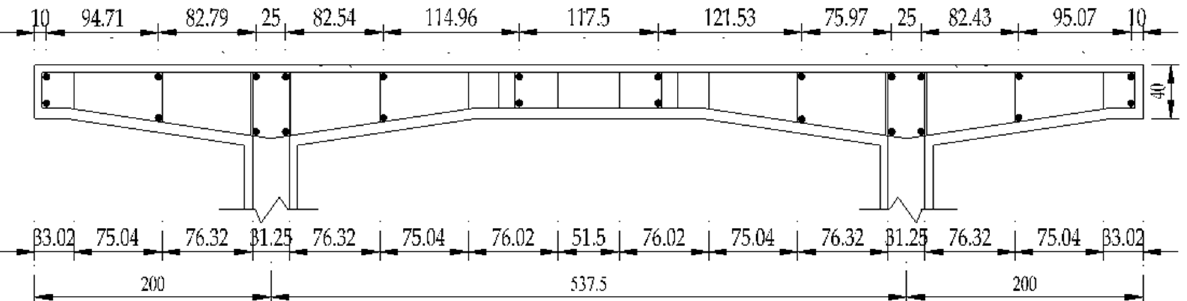
Figure 2. The transverse diagram of the bridge slab model (unit: mm).